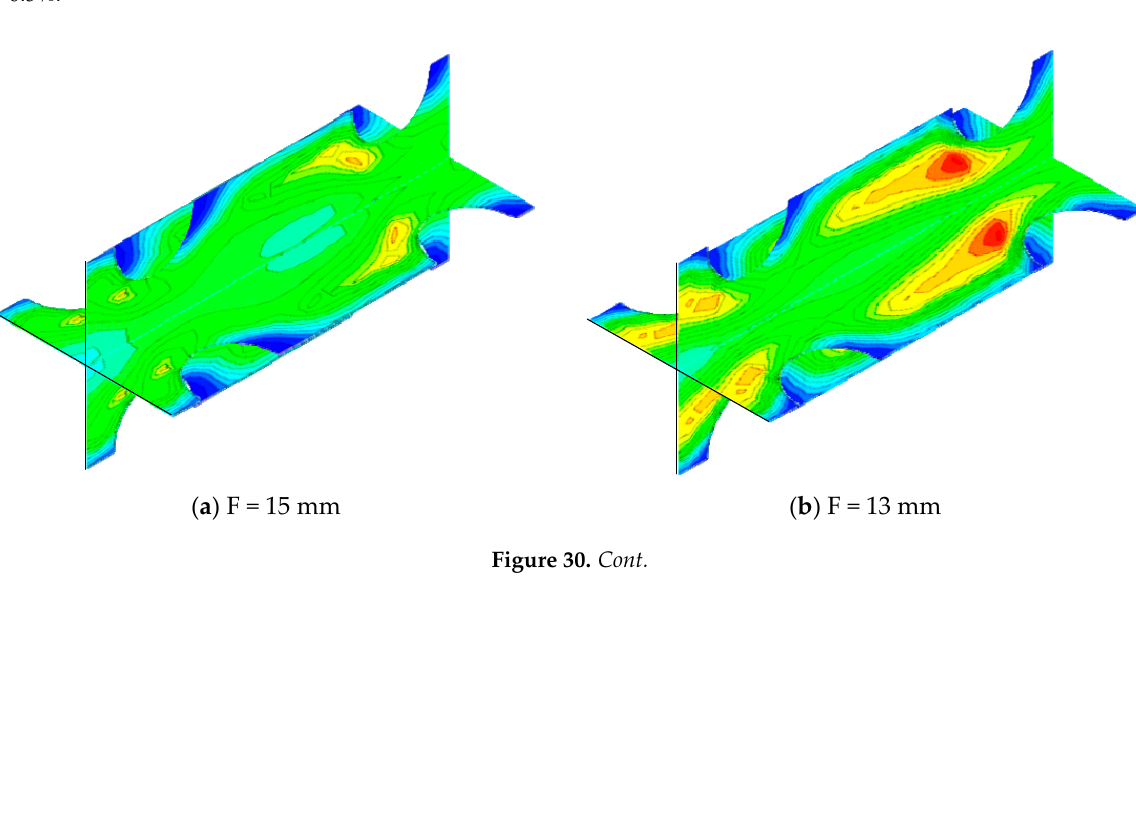
Figure 29. Temperature contours for various configurations of Case F with different F parameters at Re = 15,000, and ϕ = 0.5%.